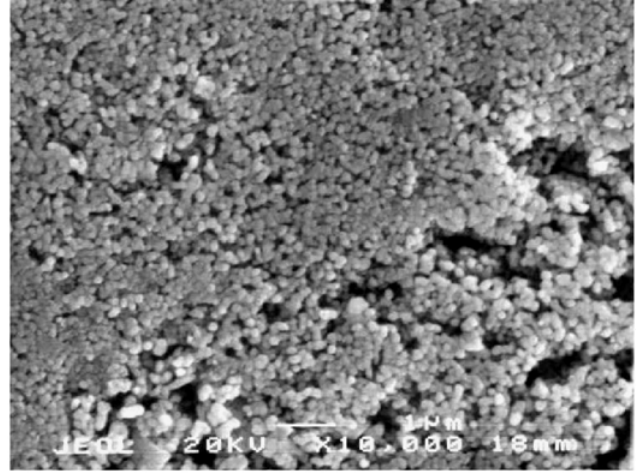
FIGURE 3 SEM picture of silver